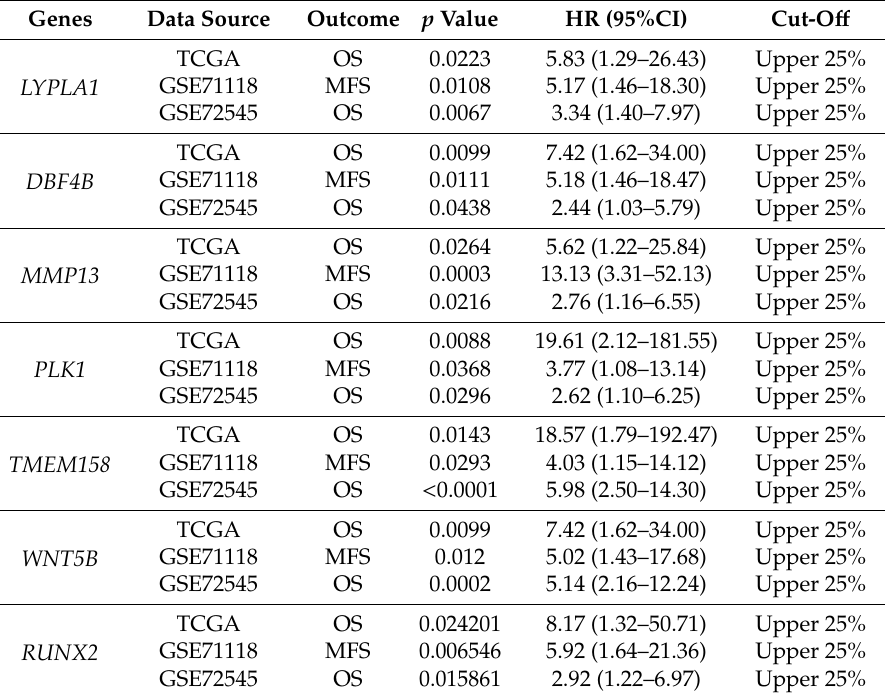
Figure 2. The Venn diagram analysis of the prognostic markers according to Cox analysis ( p < 0.05) using transcriptome data of MFS from TCGA, GSE71118, GSE72545 cohorts. Seven genes were selected out using the Venny online tool. Table 3. The novel biomarker candidates of